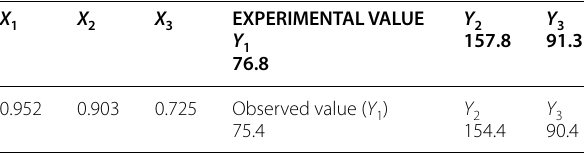
Table 4 Similarity between experimental value and observed